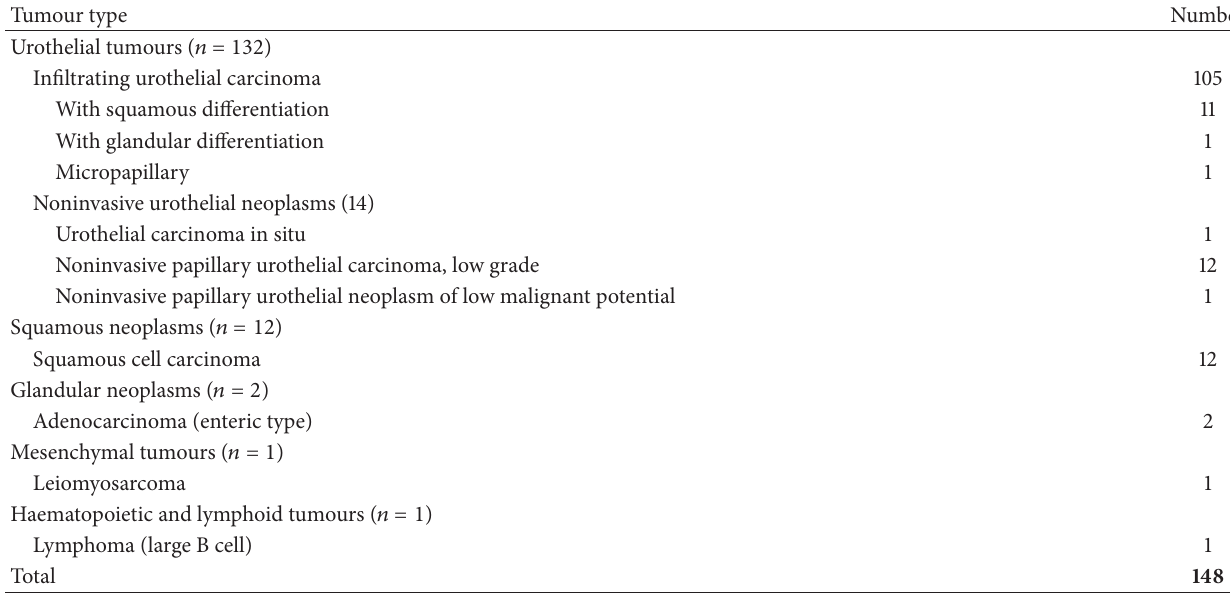
Table 2: Histological classification of tumours included in the study